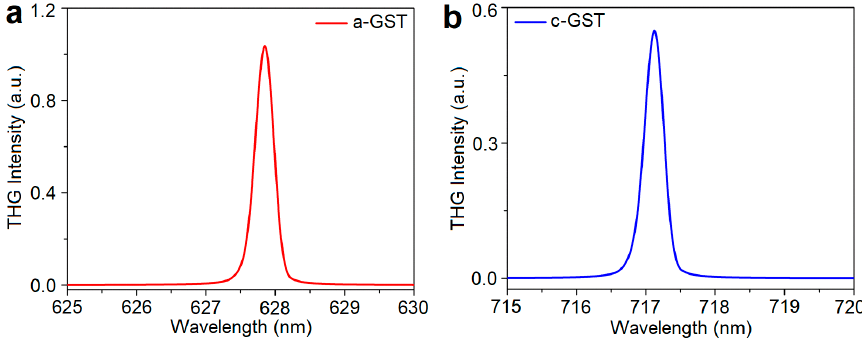
Figure 3. The third harmonic emission spectrum of ( a ) a-GST and ( b ) c-GST based metadevice.